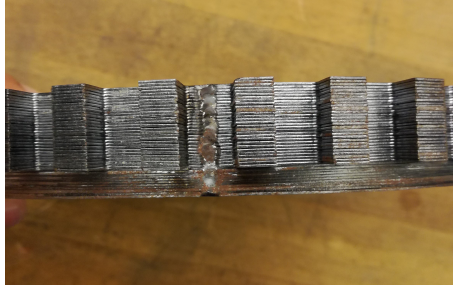
Figure 19. Details of the rotor stack structure.